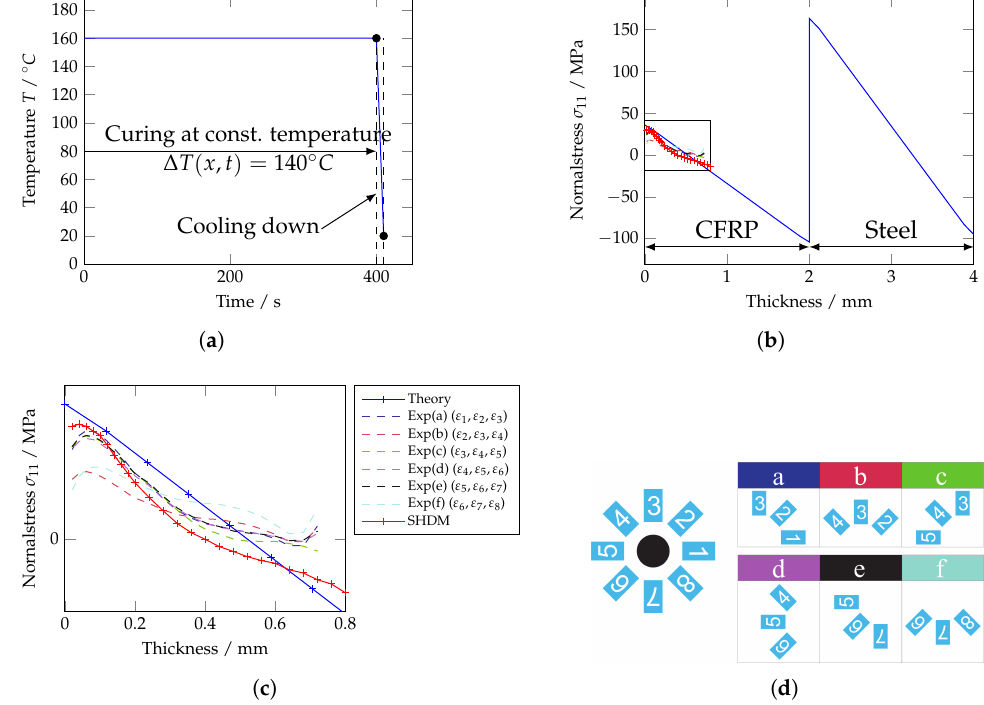
Figure 3. ( a ) Prescribed temperature-time profile T ( x , t ) for the whole domain. ( b ) Corresponding residual stress state in thickness direction after completed curing and cooling down to ambient temperature. ( c ) Validation of the predicted residual stress state in thickness direction based on results obtained by the incremental hole drilling method. For the residual stress analysis using the hole drilling method six combinations of strain gauges were used. The strain gauge combinations are depicted in ( d ) [10]. In addition, the simulated hole drilling method (SHDM) is compared with experimental results in ( c